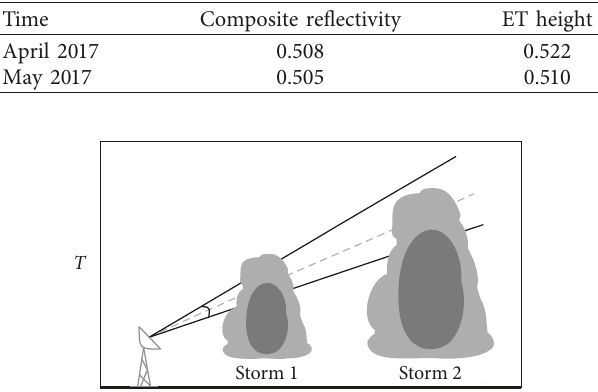
Figure 2: Schematic illustrations of two storms with the same echo intensity and different ET